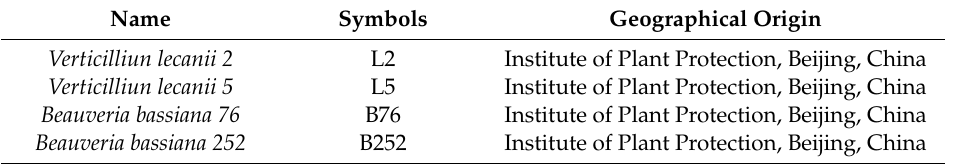
Table 4. Name of fungal strains, hosts and geographical of the entomopathogenic fungi. Name Symbols Geographical